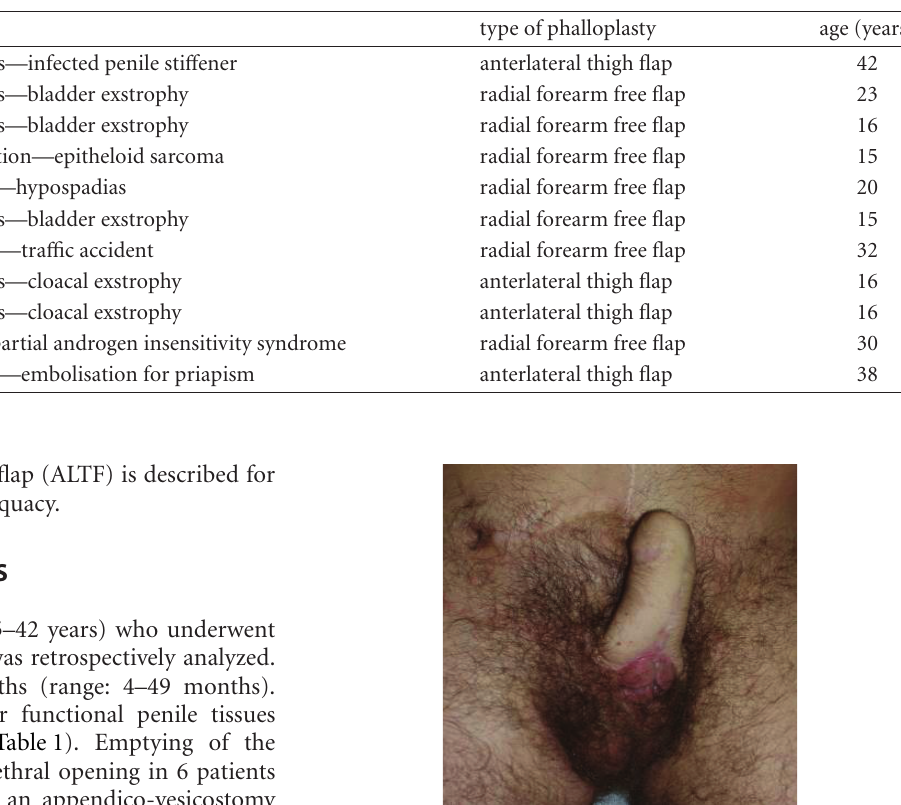
Table 1: Patients’ characteristics.